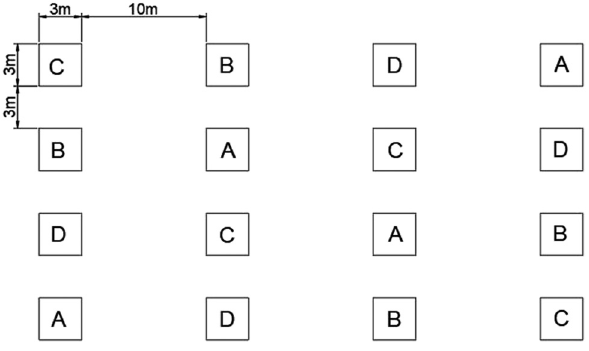
Figure 1: Placement of experimental plots in carrot cultivation